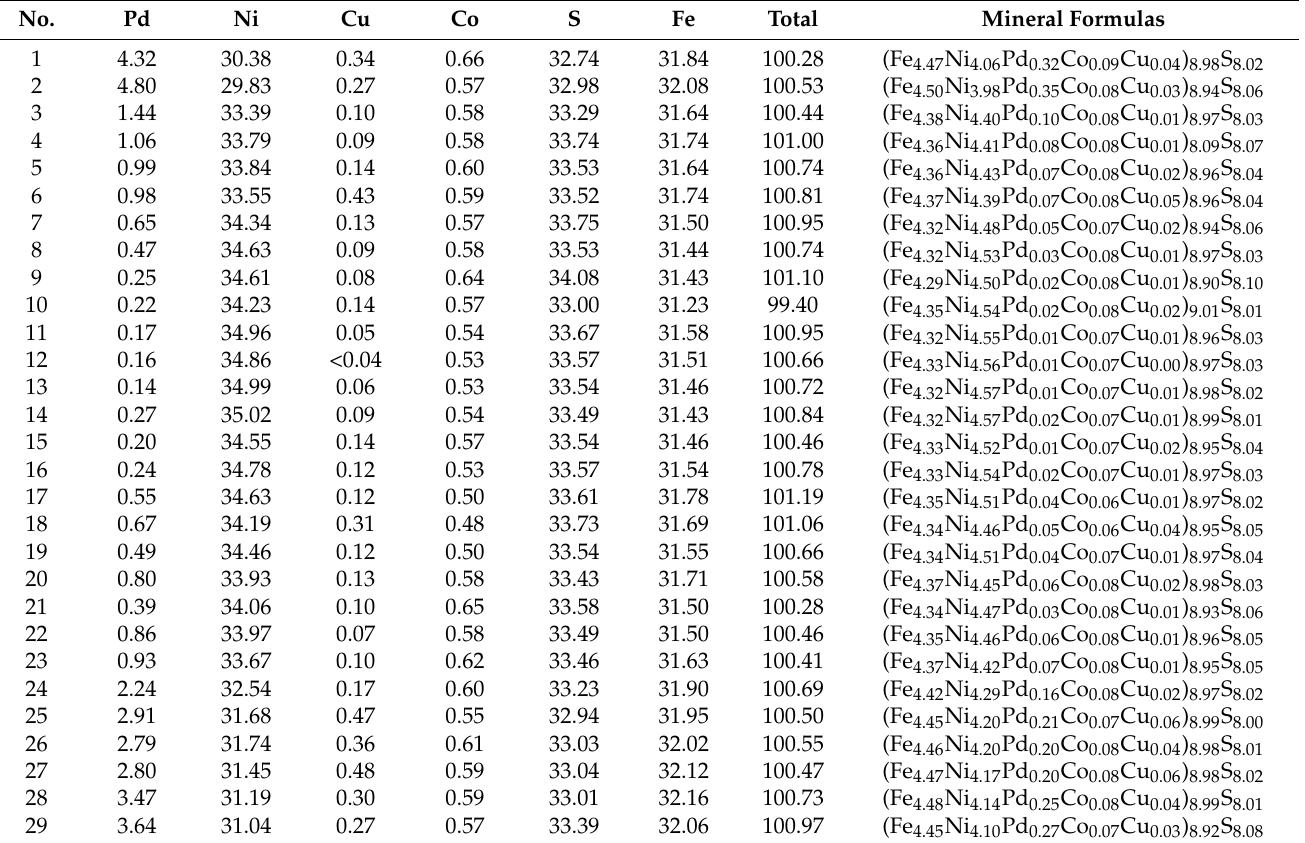
Table 4. Compositional variations in the crystal of Pd-rich pentlandite (wt.%) along the profile KK’. No.